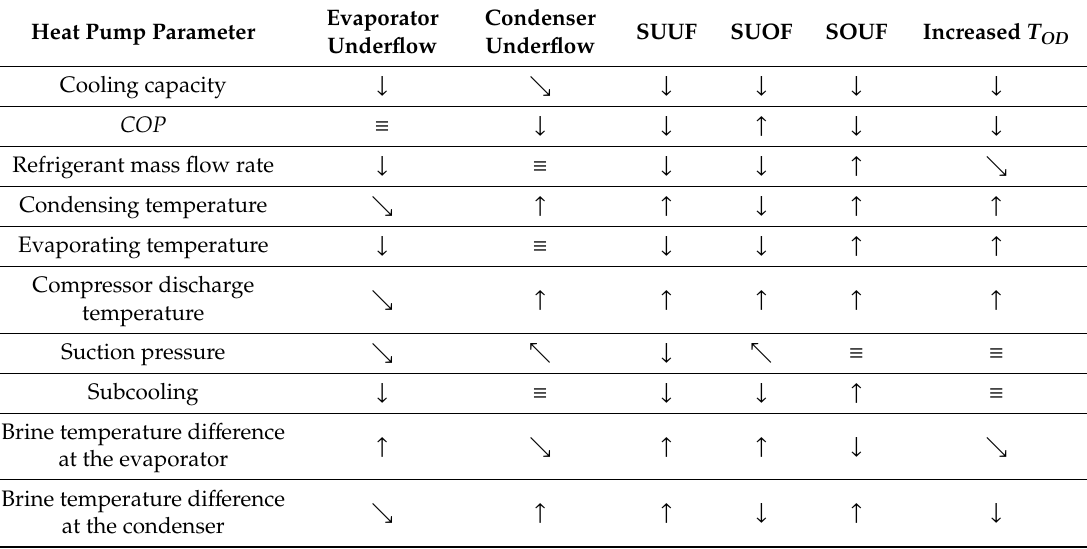
Table 6. Secondary fluid flow rate fault categorization